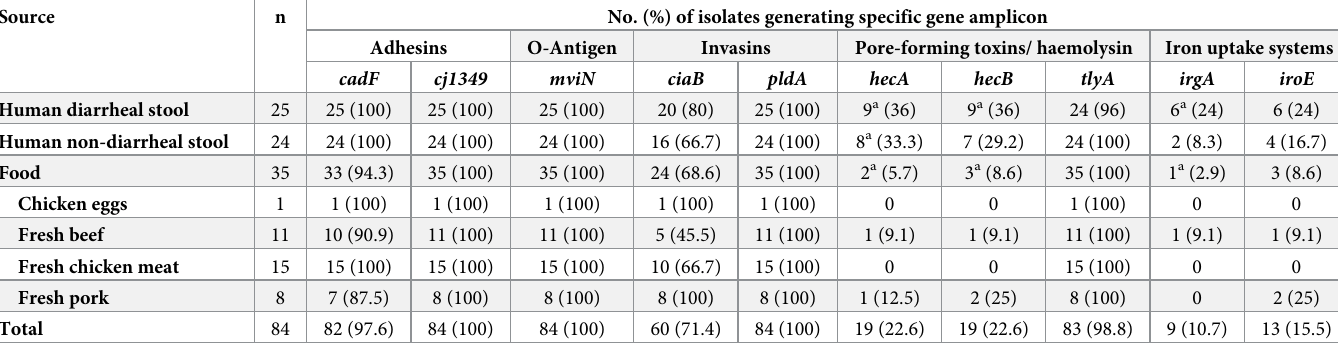
Table 2. The prevalence of the ten putative virulence genes in Arcobacter butzleri isolates from various sources. Source n